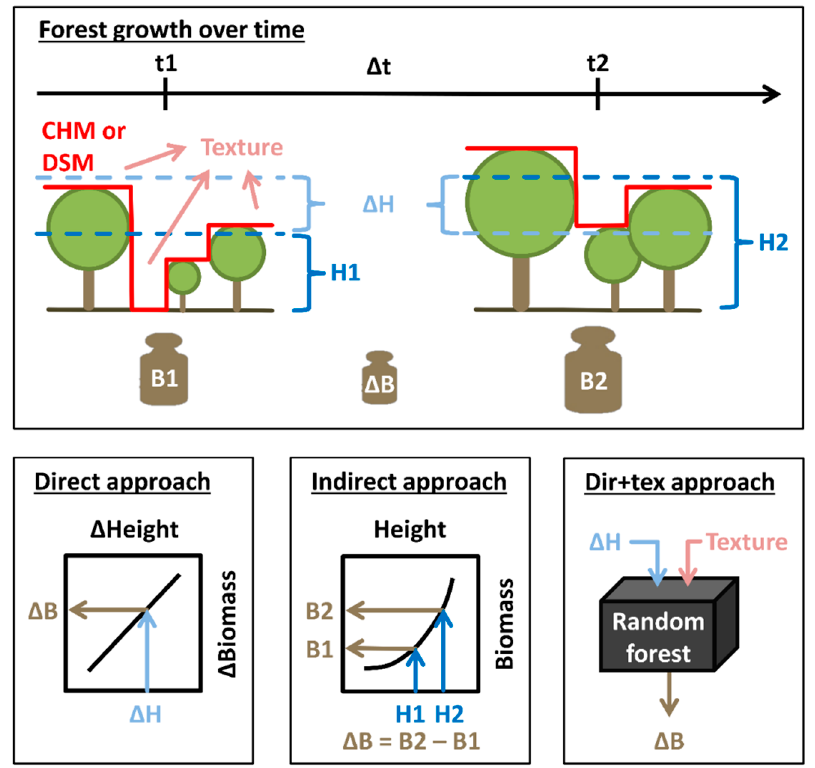
Figure 2. Inputs and principles of the three different approaches to derive biomass change ( Δ B) over time from observed canopy heights (H) or height change ( Δ H) and canopy texture, respectively. H refers to mean top-of-canopy height, obtained by averaging the CHM, indicated by red line. The direct approach and the dir+tex approach do not require absolute canopy height information, thus DSM can be used instead of CHMs.